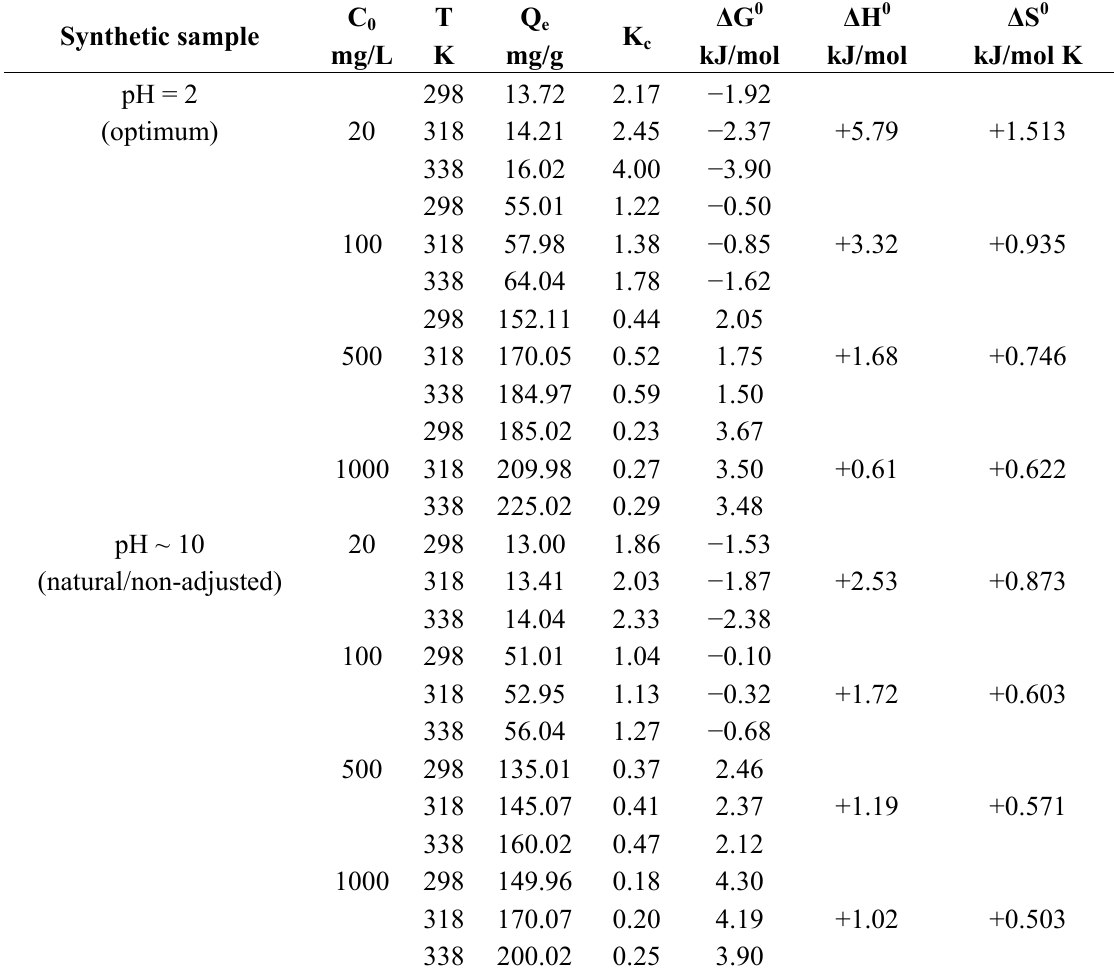
Table 3. Thermodynamic parameters for the decolorization of synthetic effluent with COF. Synthetic